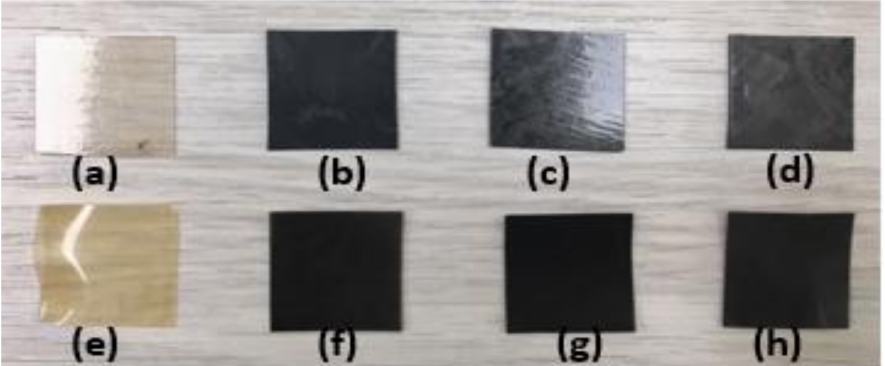
Figure 2. Samples prepared by two different techniques: ( a ) S-DF1; ( b ) S-DFG-0.5; ( c ) S-DFG-2; ( d ) S-DFG-5; ( e ) M-DF-1; ( f ) M-DFG-0.5; ( g ) M-DFG-2; and ( h ) M-DFG-5.